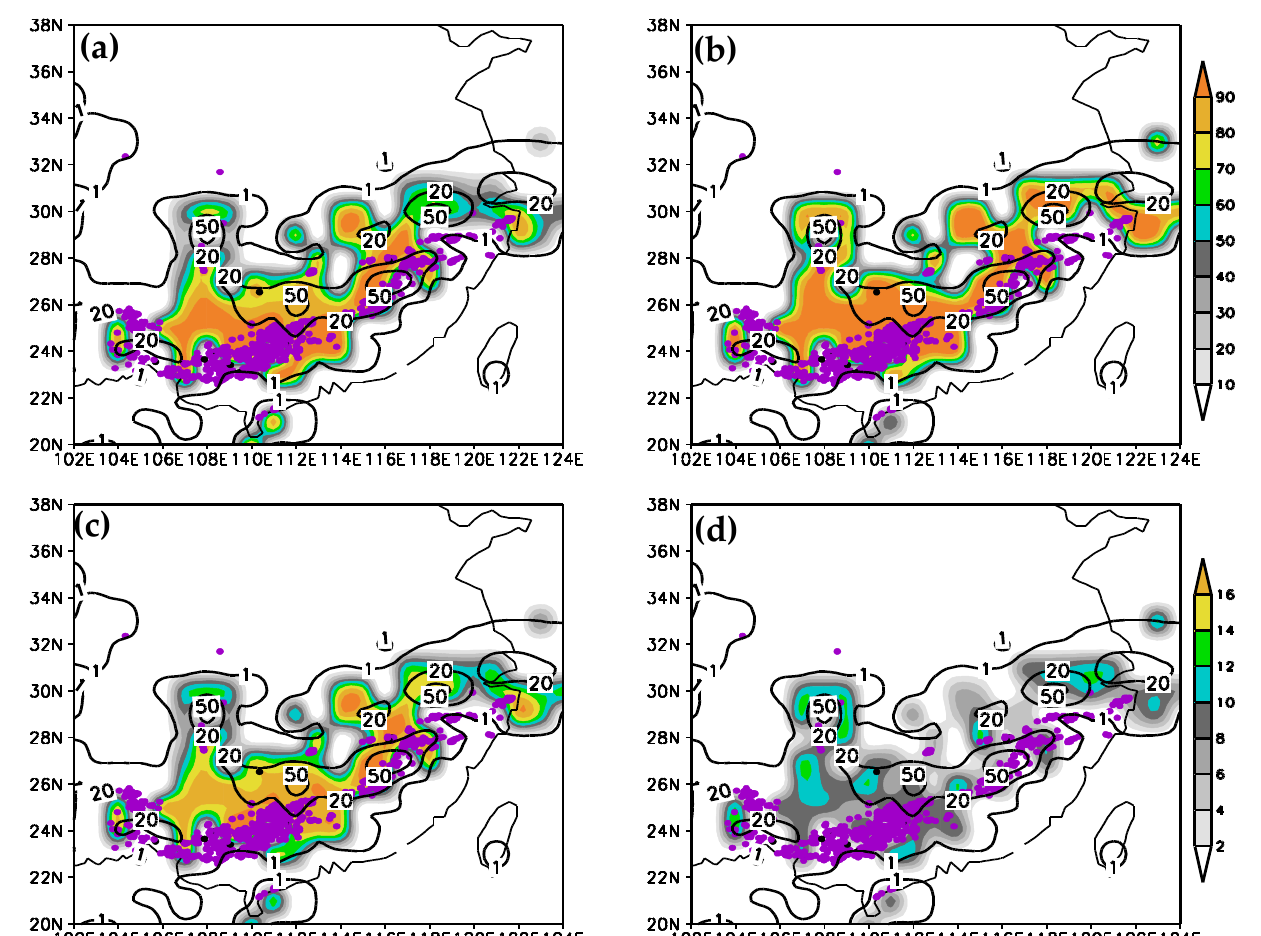
Figure 10. Comparison of predicted 48-hour SDHR probability (shaded) valid at 20:00 BT; ( a ) is for the maximum CSI group with weights of No. 1 in Table 4, ( b ) is for the maximum CSI ave group with weights of No. 6 in Table 4, ( c ) is the average of the 84 groups, and ( d ) is the corresponding standard deviation of ( c ). The available SDHR observations reported by AWS from 17:00 to 23:00 BT on 15 May 2015 are shown as purple dots. The solid lines in each panel are the NCEP-GFS-predicted six-hour rainfall accumulation (mm) from 17:00 to 23:00 BT on 15 May 2015.